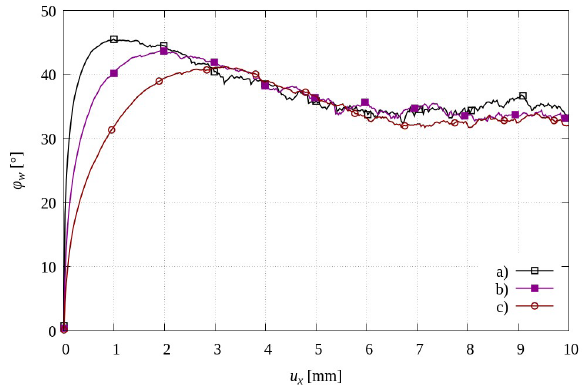
versus horizontal displacement w = 200 kPa and c) σ = 500 kPa ( e 0 0